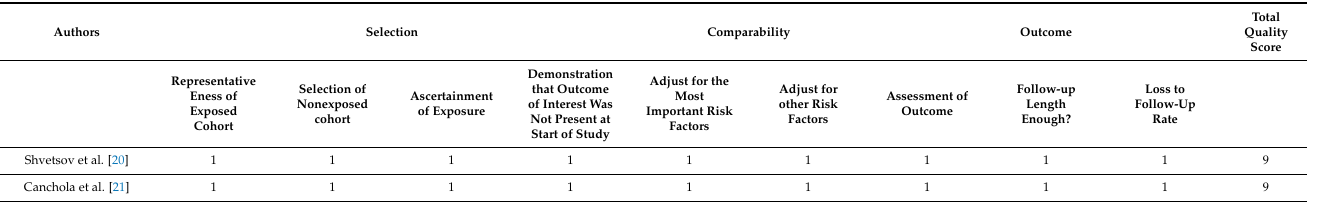
Table 2. A quality assessment of cohort studies included in the systematic review using Newcastle- Ottawa Quality Assessment Form for Cohort